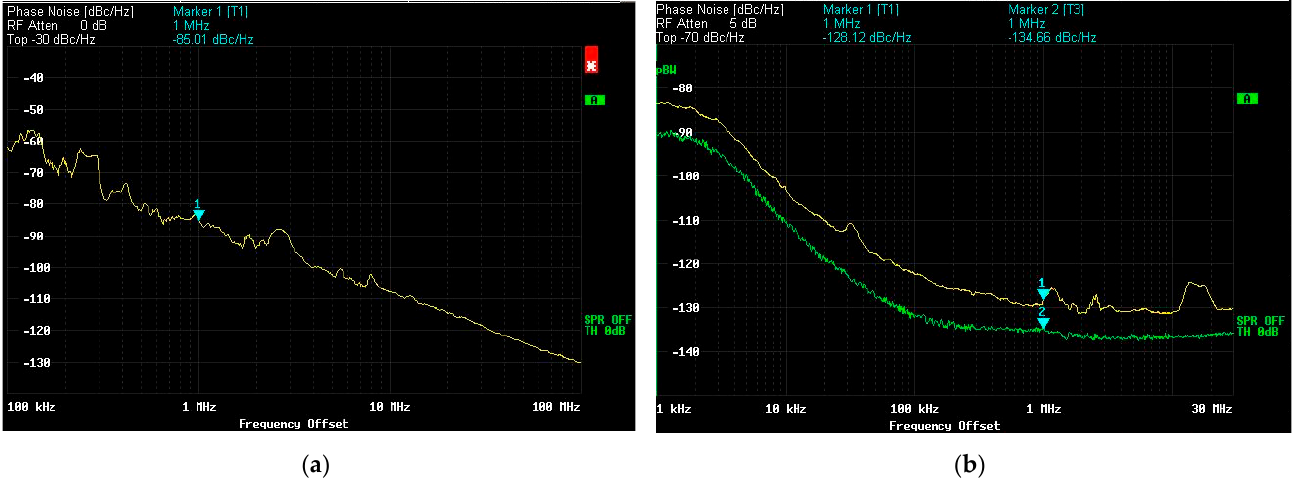
Figure 10. Phase noise ( a ) without injection locking; ( b ) comparison of the PLL under injection locking (yellow curve) vs. the input data signal (green curve).